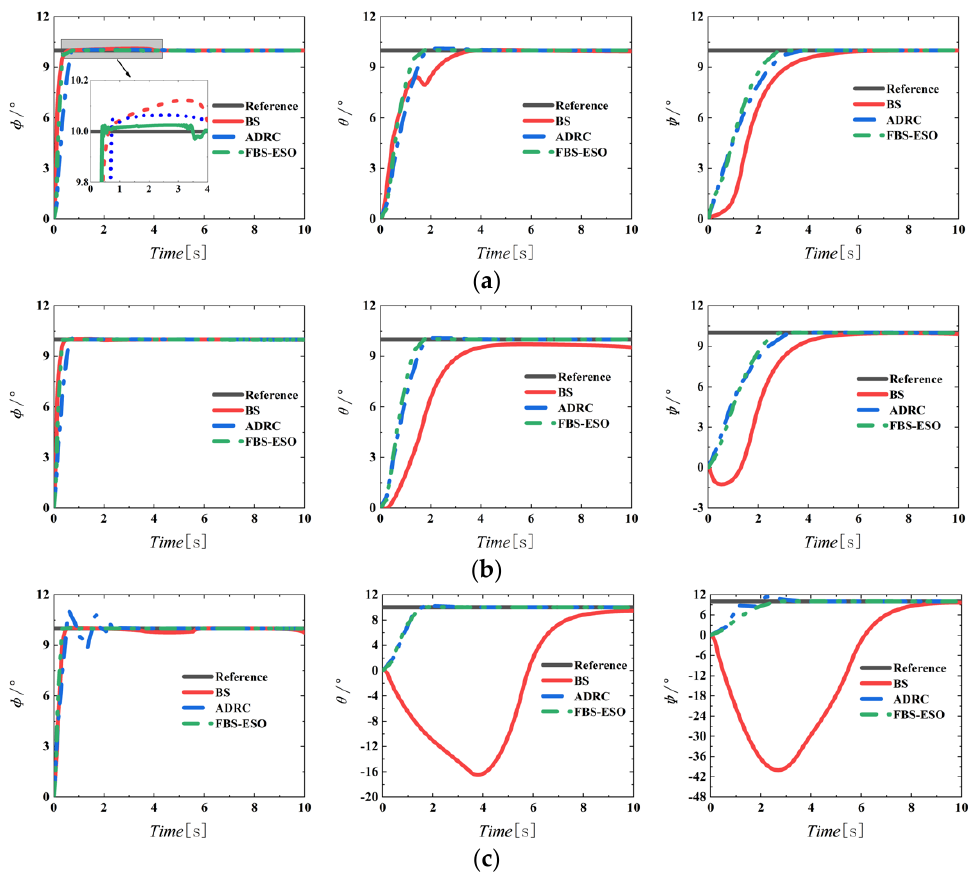
Figure 7. Response curves of the steady-state tests. ( a ) β t = 90 ◦ (helicopter mode); ( b ) β t = 45 ◦ (transition mode); and ( c ) β t = 0 ◦ (fixed-wing